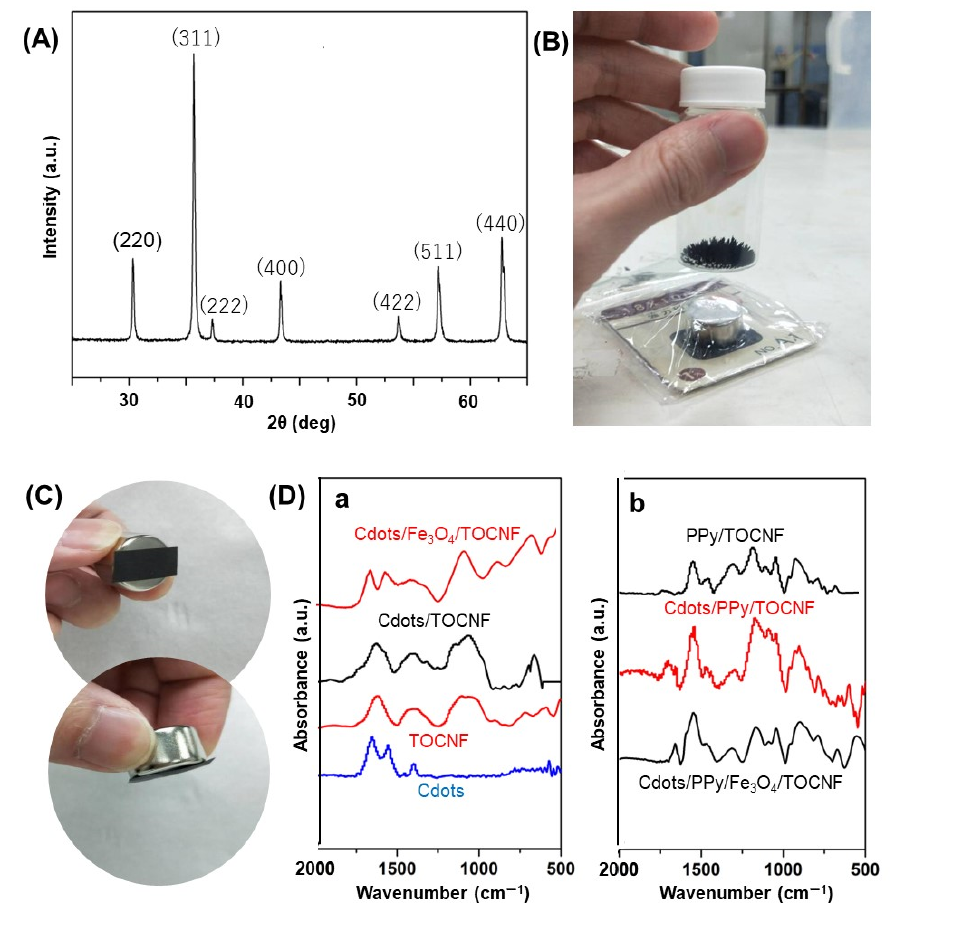
Figure 2. ( A ) An XRD pattern of Fe 3 O 4 NWs, ( B ) an image of Fe 3 O 4 NWs on a magnet, ( C ) images of an Fe 3 O 4 /TOCNF film on a magnet and ( D ) a,b IR absorption spectra of Cdots and various TOCNF films.